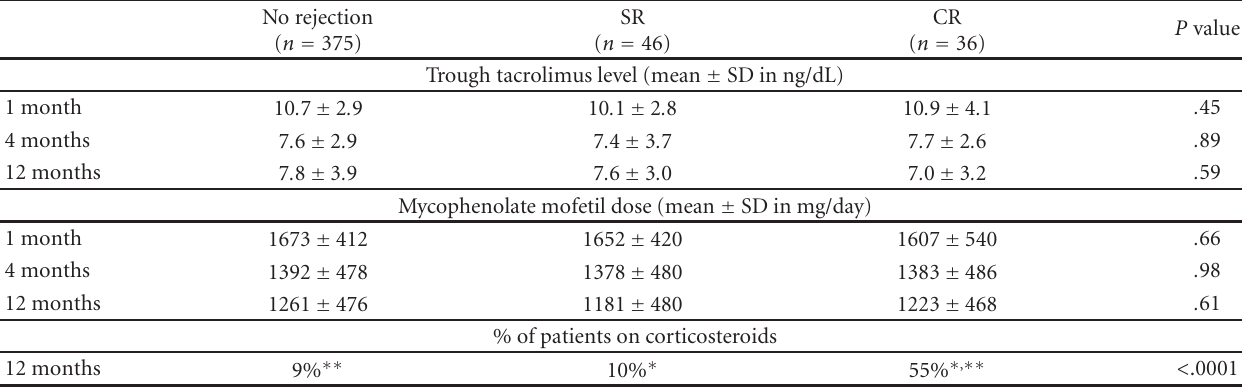
Table 2: Immunosuppression management during the first posttransplant